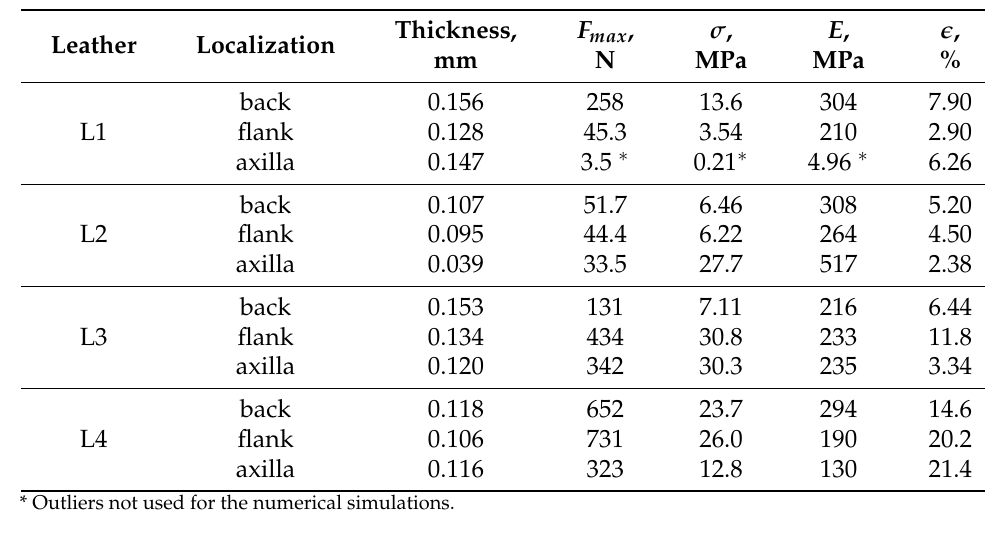
Table 2. Experimental results for tension tests on fiber-bundles.